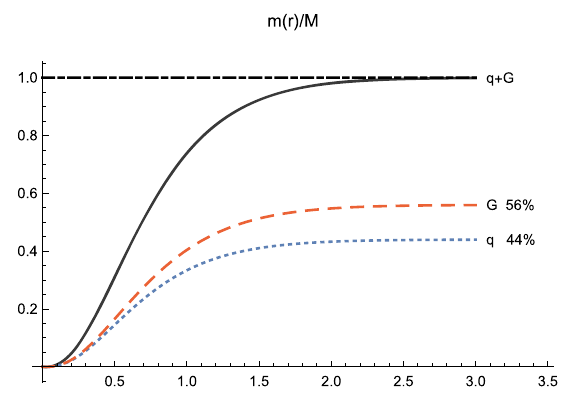
Fig. 3 Quark,gluonandtotalmassfunctions,computedusingthemul- tipole model (11) with parameters given in Table 1, see Eq. (45) for the definition